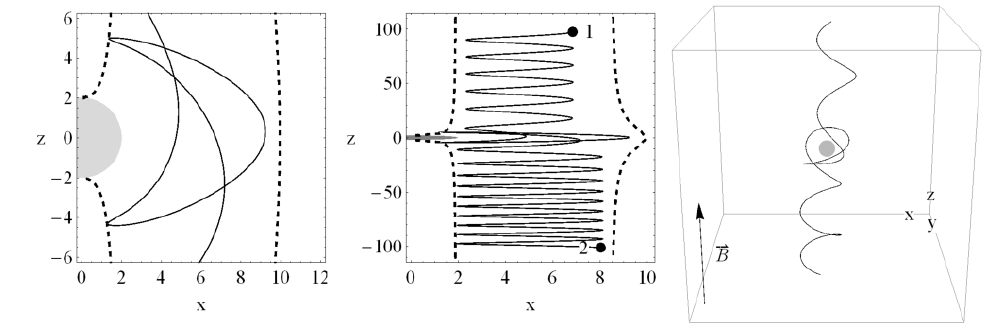
Figure 11. Charged particle trajectory representing the chaotic scattering in the field of a magnetized black